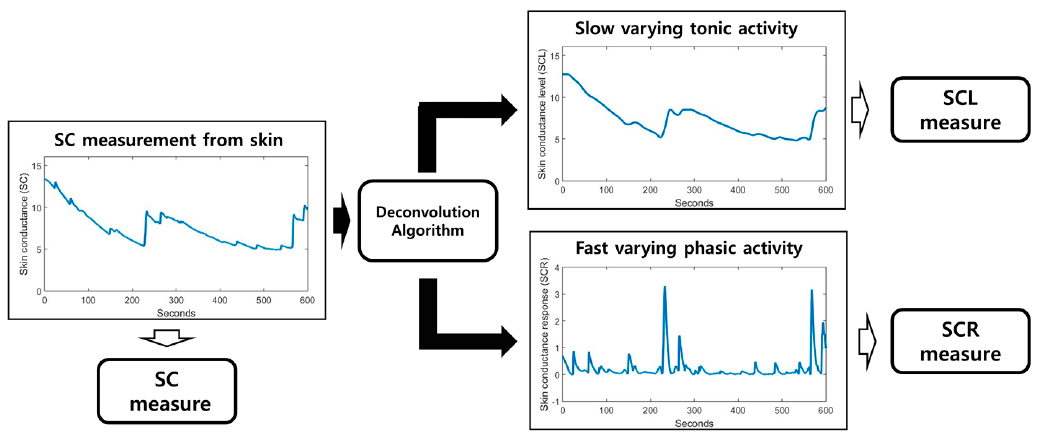
Figure 3 . Block diagram for SC analysis. The SCL and SCR can be obtained by deconvoluting the SC signal.